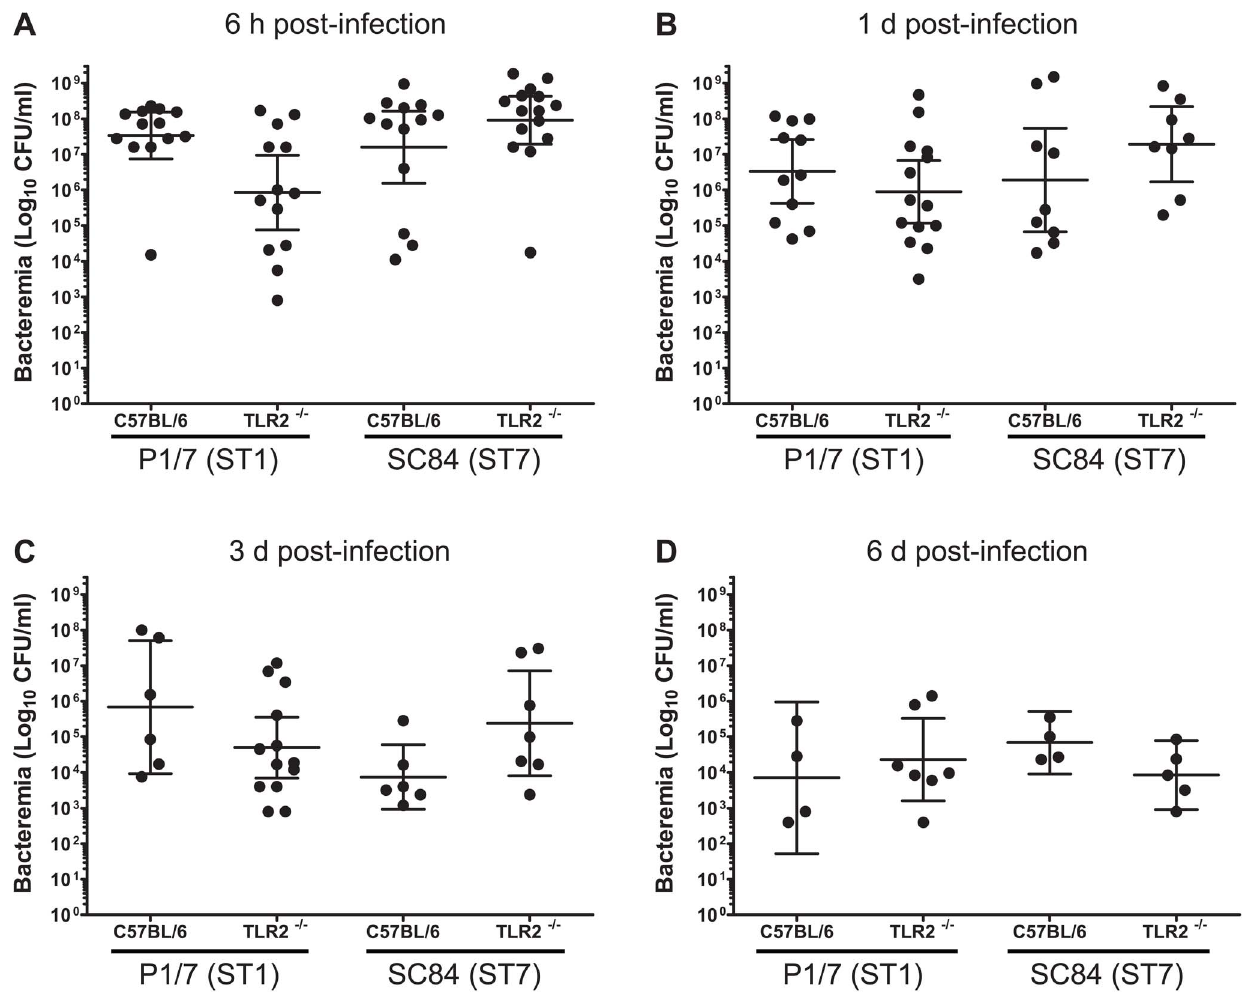
Figure 2. Blood bacteremia of S.suis highly virulent strain ST1 and epidemic strain ST7 is similar in C57BL/6 and TLR2 2 / 2 mice. C57BL/6 mice ( n =13 mice per group) or TLR2 2 / 2 mice ( n =14 mice per group) were inoculated by intraperitoneal injection with 1 6 10 7 CFU of either S. suis strain P1/7 (ST1) or SC84 (ST7). At 6 h (panel A), day 1 (panel B), day 3 (panel C), and day 6 (panel D) post-infection, 5 m l of blood was harvested from the tail of infected mice and proper dilutions were plated on blood agar plate to assess blood bacteremia. Data of individuals are presented including geometric mean with 95% confidence interval. No significant differences ( P . 0.05) between infected TLR2 2 / 2 mice and their WT counterpart were observed as determined by